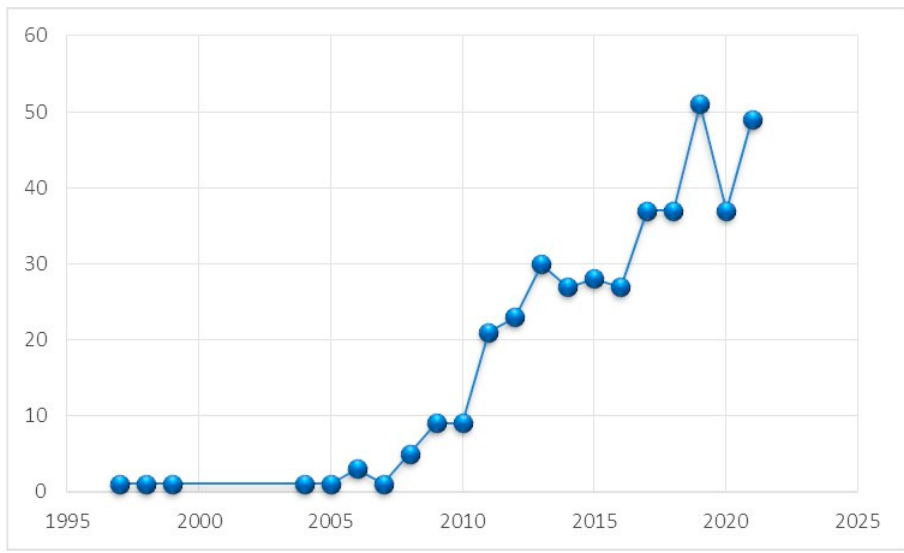
Figure 2. Total number of publications on salivary biomarkers from 1997 to 2021.